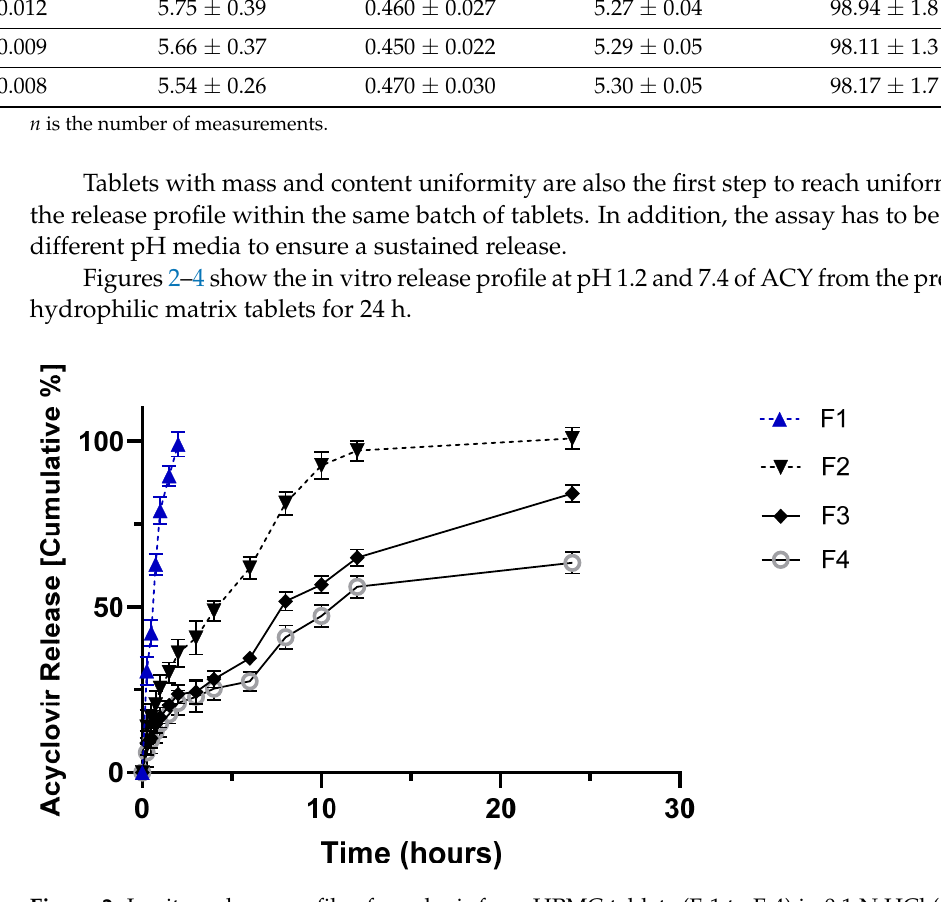
Figure 3. In vitro release profile of acyclovir from Carbopol tablets (F-5 to F-8) in 0.1 N HCl (pH 1.2) from zero to two hours, after which 200 mL of 0.2 M sodium phosphate tribasic solution was added to reach a final pH of 7.4 kept for the remaining 24 h. Please refer to Table 7 for tablets’ composition.